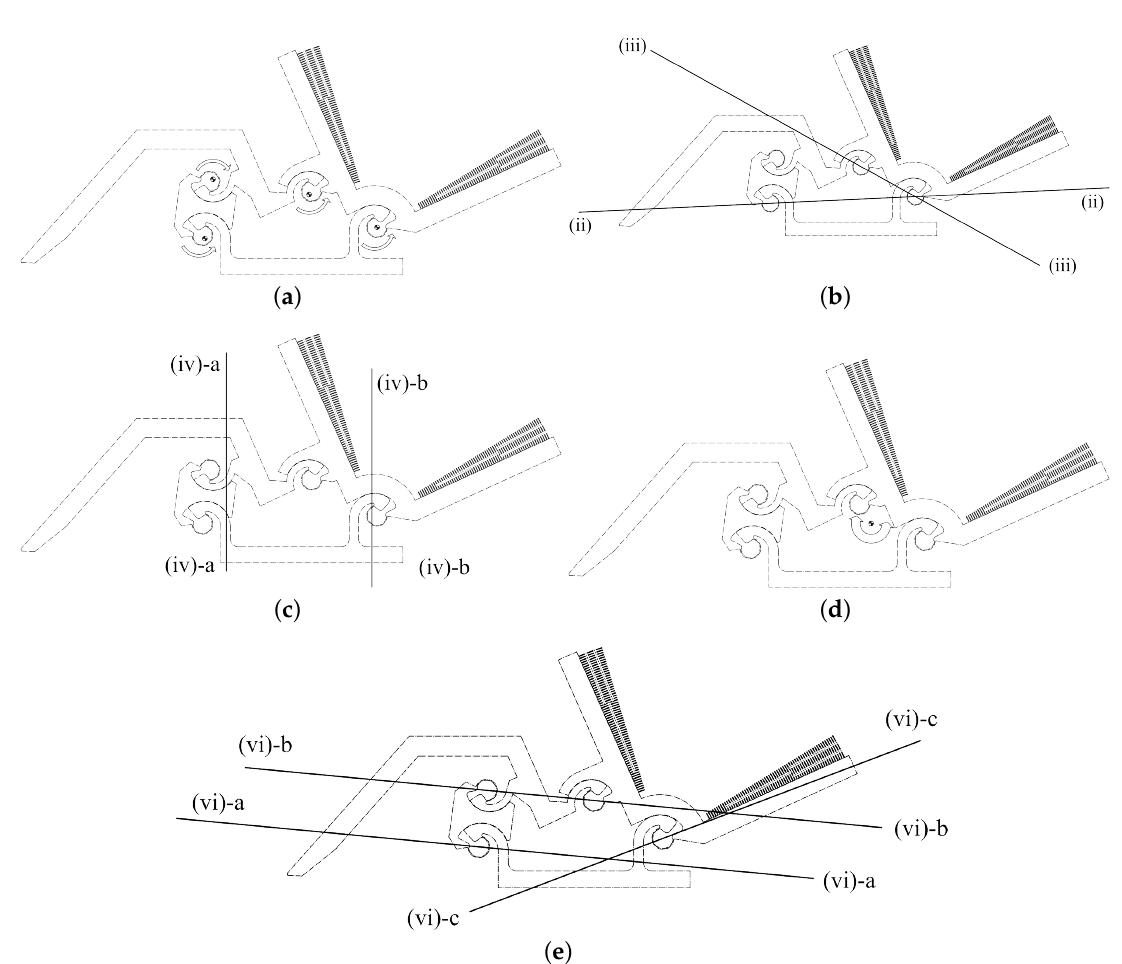
Figure 9. Pseudo-axes of rotation corresponding to the first 6 vibrational modes: ( a ) In-plane rotation axes for mode (i); ( b ) Out-plane rotation axes for modes (ii) and (iii); ( c ) Out-plane rotation axis for